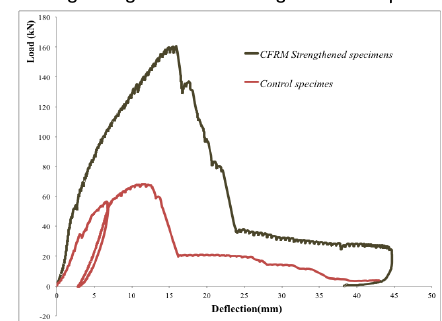
Figure 11: Testing configuration for strengthened sample Figure 12: Collapse mode for the strengthened sample